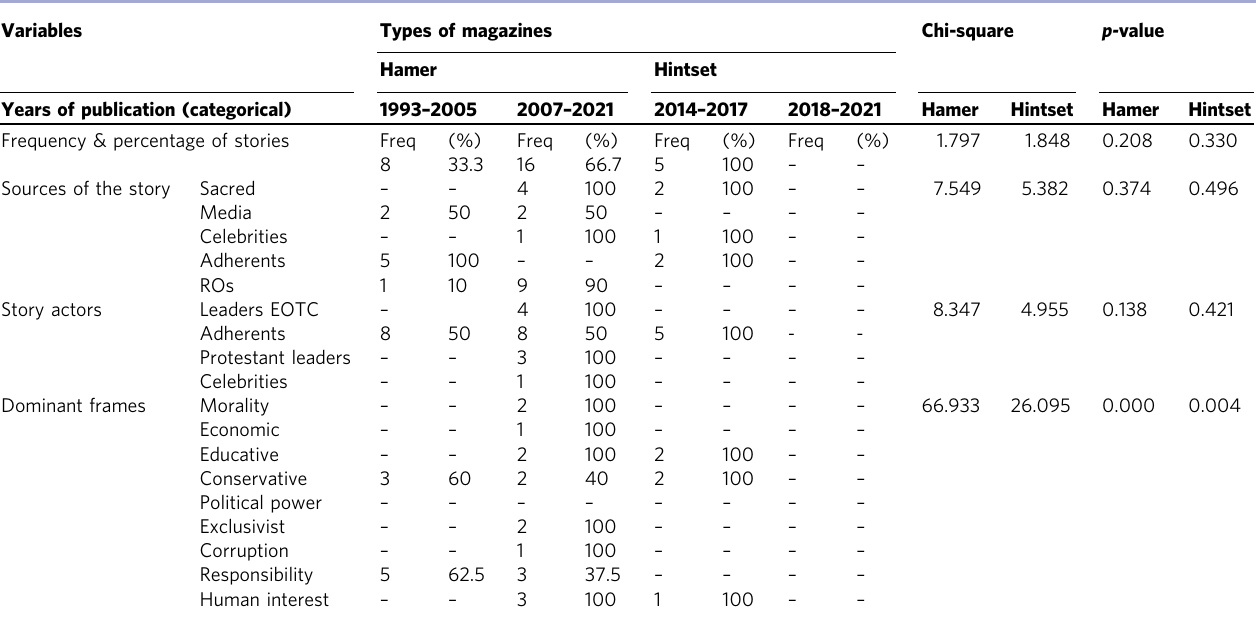
Table 4 Cross-Tabulation: Cultural development * Types of publication * Years of publication * Sources * Story actors * Dominant